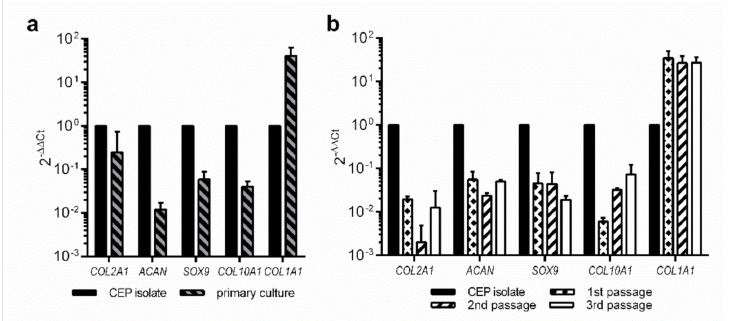
Figure 3. Comparison of CEP isolates and primary cultures at mRNA level. ( a ) Comparison of a fresh CEP isolate ( n = 1) and primary cultures of the cells isolated from CEPs ( n = 4). ( b ) Comparison of three consecutive passages of the primary cultures ( n =